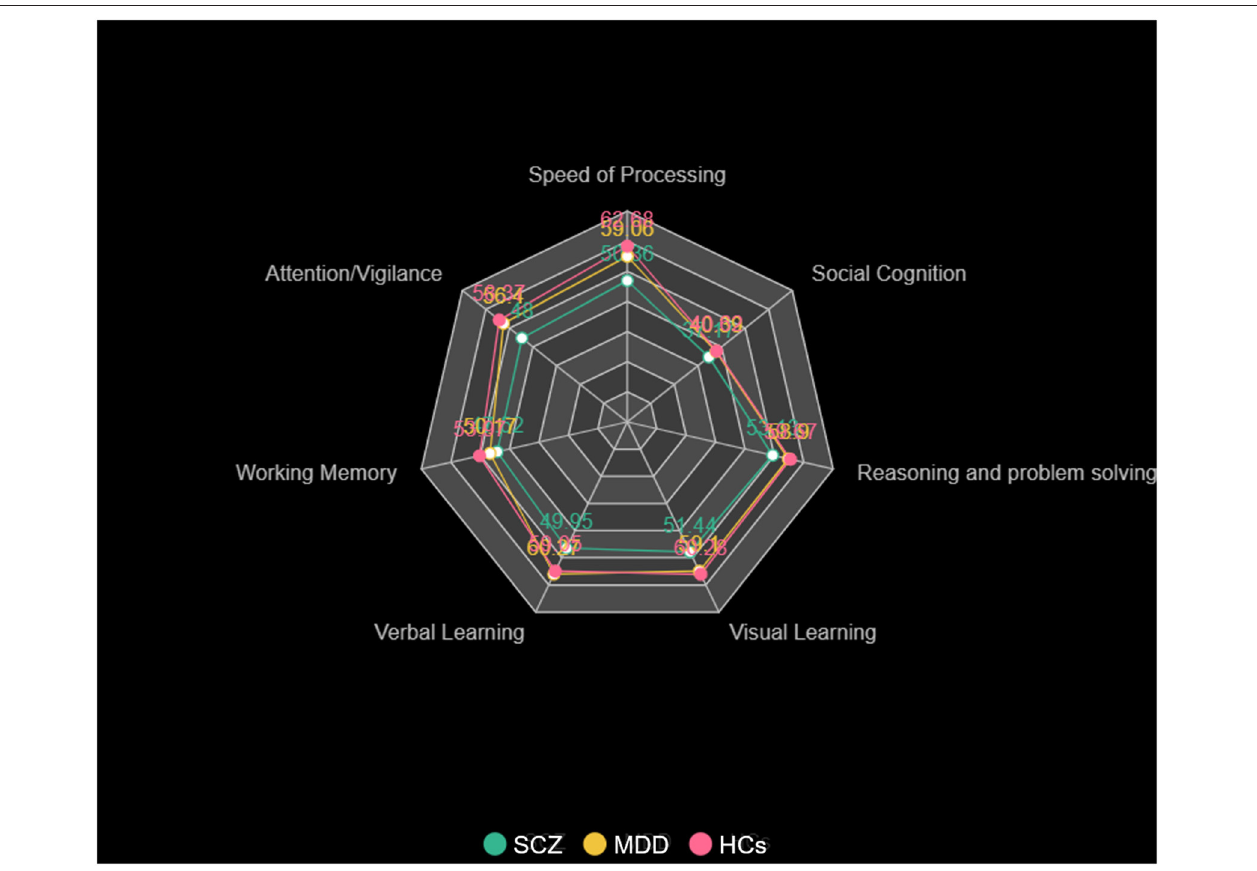
FIGURE 1 | Cognitive function of patients with SCZ, patients with MDD, and HCs. The cognitive scores for processing speed, attention/vigilance, working memory, verbal learning, visual learning, reasoning, problem solving, and social cognition in patients with SCZ, patients with MDD, and HCs.